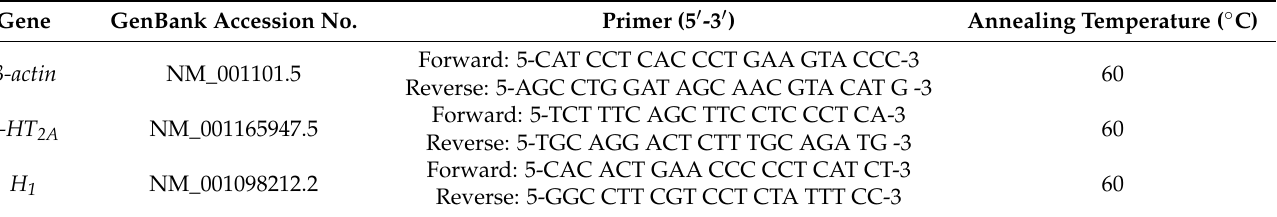
Table 1. Primers Used for Real-Time PCR